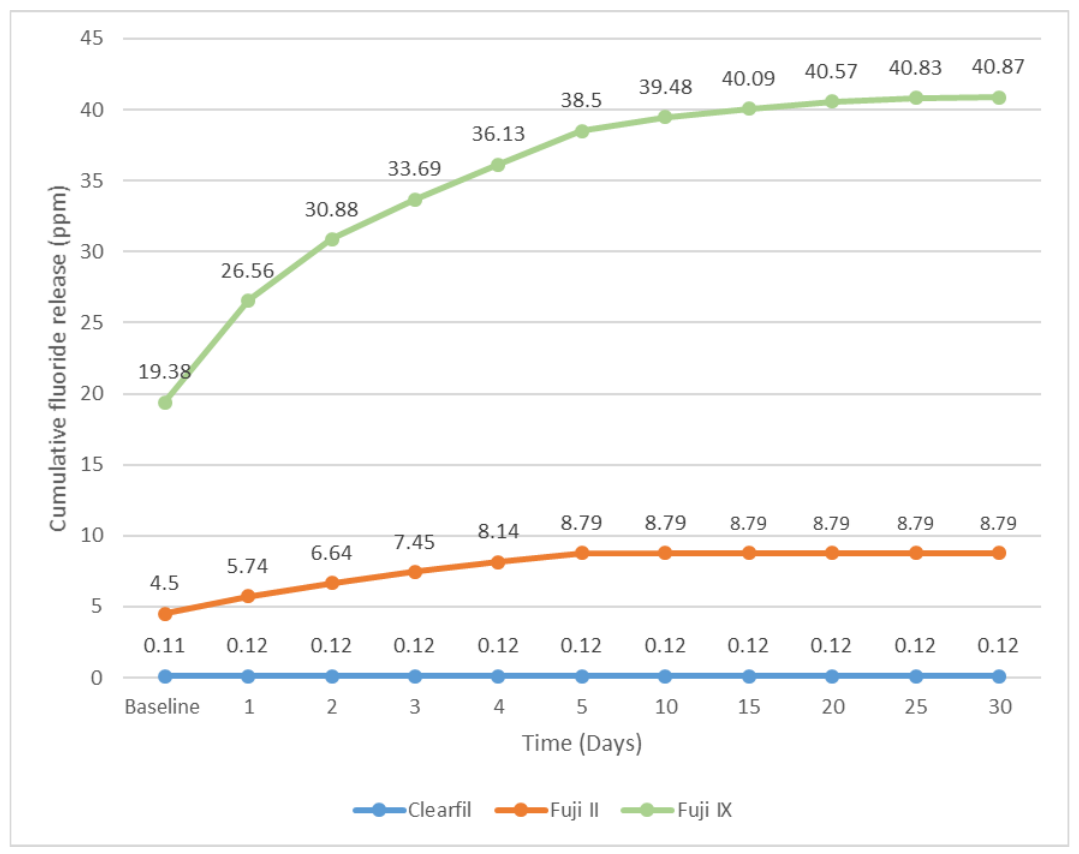
Figure 3. Comparison of cumulative Fluoride release over 30 days among the three materials.